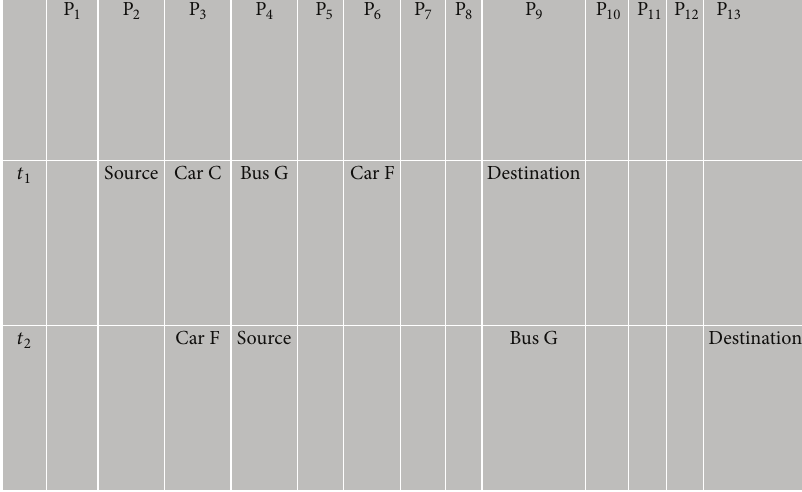
Figure 4: Timing diagram showing new position of nodes.